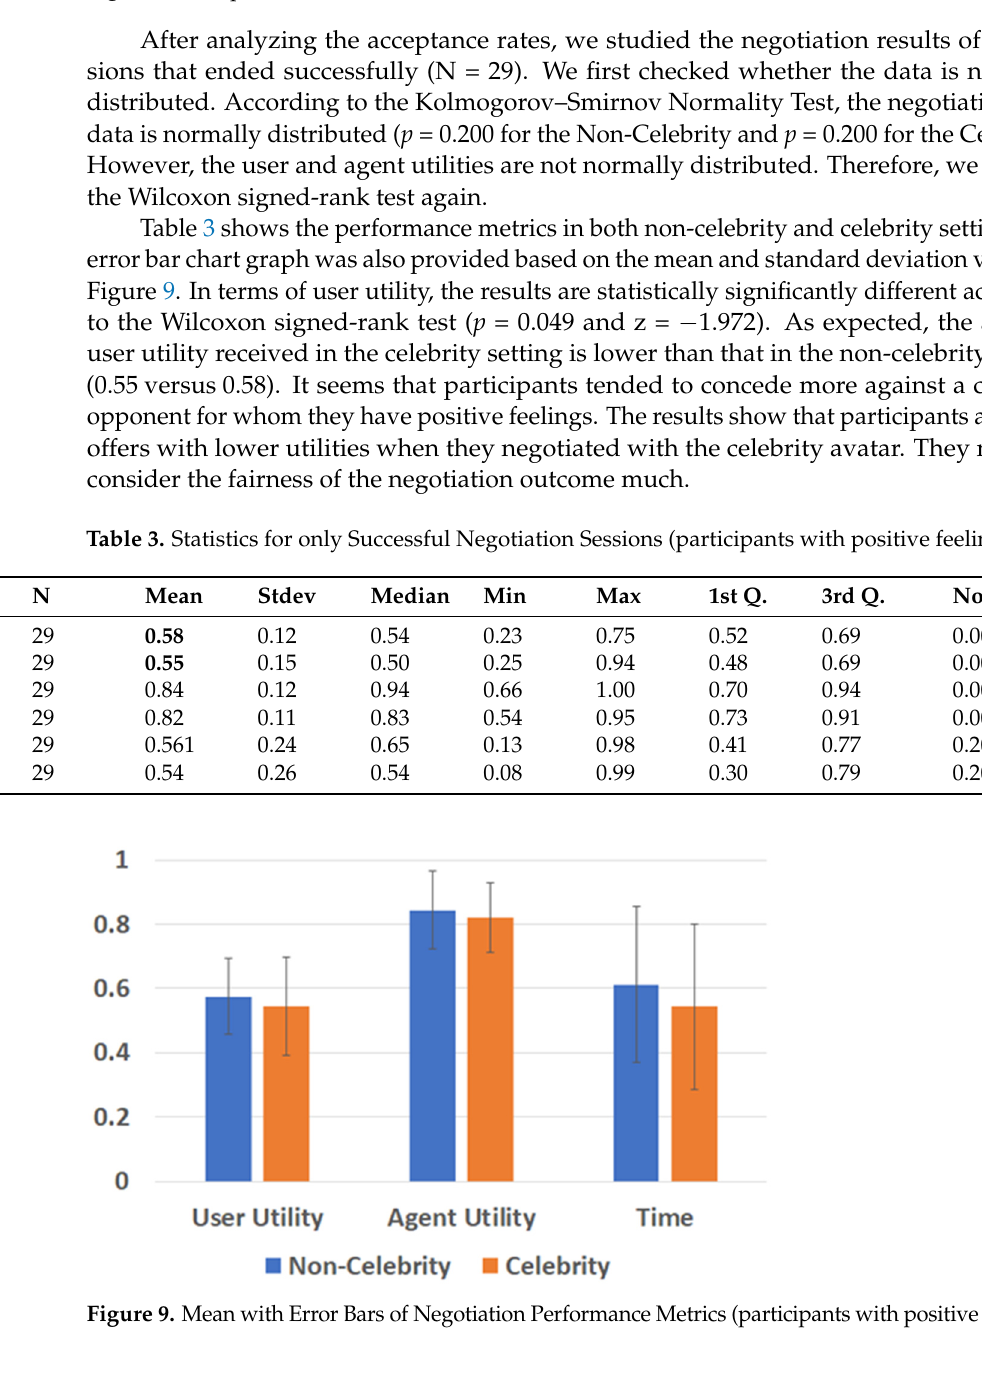
Figure 8. Acceptance Rates for H2 Related Data.